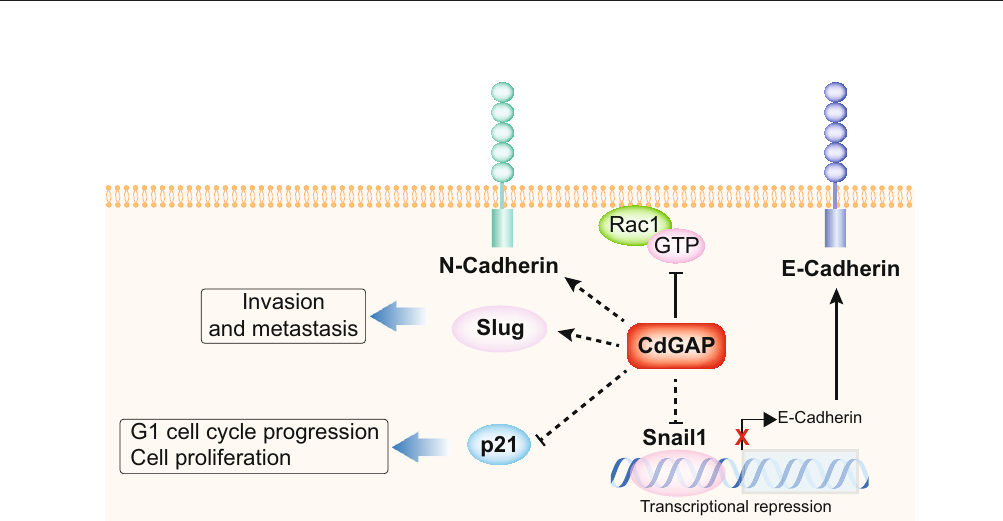
Fig. 8 CdGAP controls metastatic progression. a – d Weight, volume, and density of primary tumors and representative photographs of primary tumors collected from control (shCon) or CdGAP-depleted (shCdGAP) PC-3 cells-injected mice at the experimental endpoint (28 days) (shCon: n = 5; shCdGAP: n = 6). Two-sample unpaired Student ’ s t test for comparison between two groups (shCon; shCdGAP). Error bars indicate SEM. ns: not signi fi cant. e Representative images of H&E staining of primary tumors. f Quanti fi cation of apoptotic cells in primary tumors by assessing the percentage of cleaved caspase-3 positive cells (shCon: n = 5; shCdGAP: n = 6). Representative images of IHC staining of cleaved caspase-3 in primary tumors. Two-sample unpaired Student ’ s t test for comparison between two groups (shCon; shCdGAP). Error bars indicate SEM. ** p < 0.01. g Representative images of metastases found in control or CdGAP-depleted PC-3 cells-injected mice following ex vivo bioluminescent imaging at the experimental endpoint (28 days). Each mouse was exposed for 4 min after removal of the primary tumor. Yellow circle, intestine; orange circle, testis; red arrow, kidney; green arrows, legs. h Percentage (number; #) of mice with local and distant metastases quanti fi ed following ex vivo bioluminescent imaging at the experimental endpoint (28 days). The average number (#) of intestine lesions was quanti fi ed in each control and shCdGAP mice with metastases. i Representative images of H&E staining of the kidneys from control (shCon) or CdGAP-depleted (shCdGAP) PC-3 cells-injected mice. Black arrows show tumor lesions. j Violin plots of CdGAP intensity as scored in benign adjacent (BA) and matched tumor (T) tissue cores from the TF123 TMA ( n = 282; cytoplasm, p = 1.2 × 10 − 21 ; nucleus, p = 0.013; Wilcoxon rank-sum test). k Kaplan – Meier curves of bone metastasis-free survival (10 years) based on CdGAP cytoplasmic staining in tumor cores from the TF123 TMA ( p = 0.057). l Univariable analyses revealed that high CdGAP expression in tumor (CdGAP-T) cores are a prognostic factor for progression to bone metastasis (Supplementary Table 2).